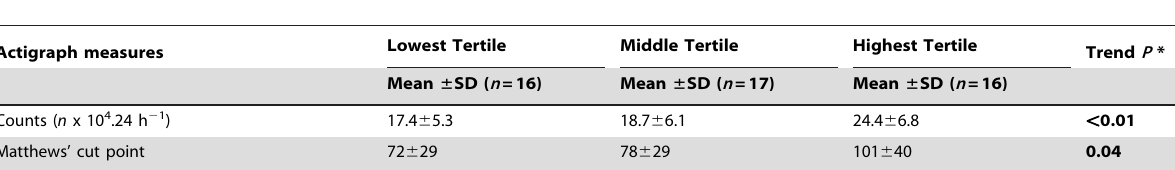
Table 6. Mean (SD) GT1M values across tertiles of total energy expenditure based on the PPAQ.